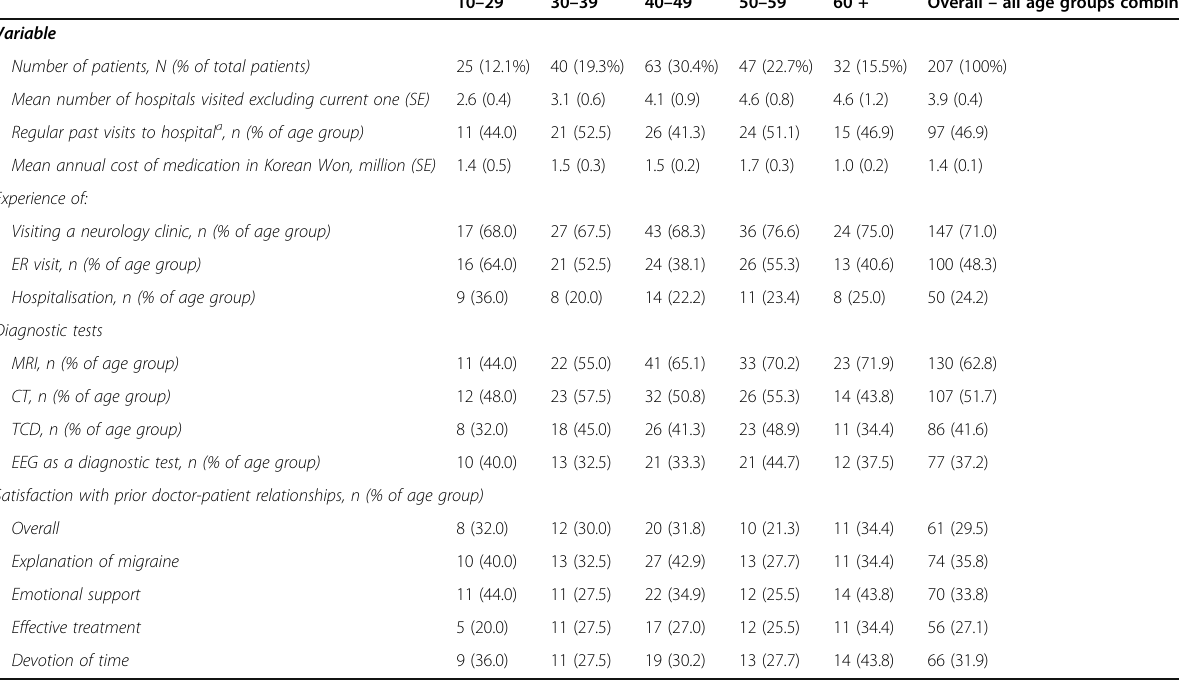
Table 2 Prior utilization of medical services and cost of medication for migraine